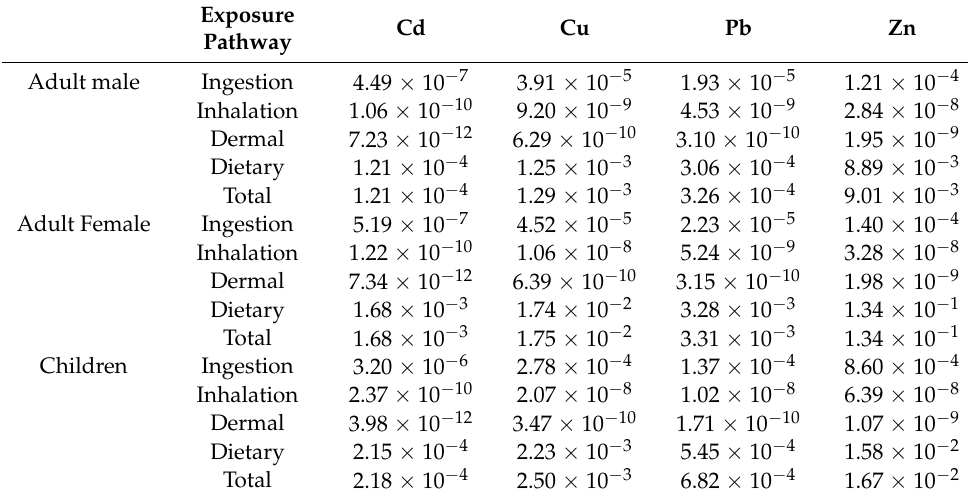
Table 5. Estimated exposure does (mg · kg − 1 · day − 1 ) from the different exposure